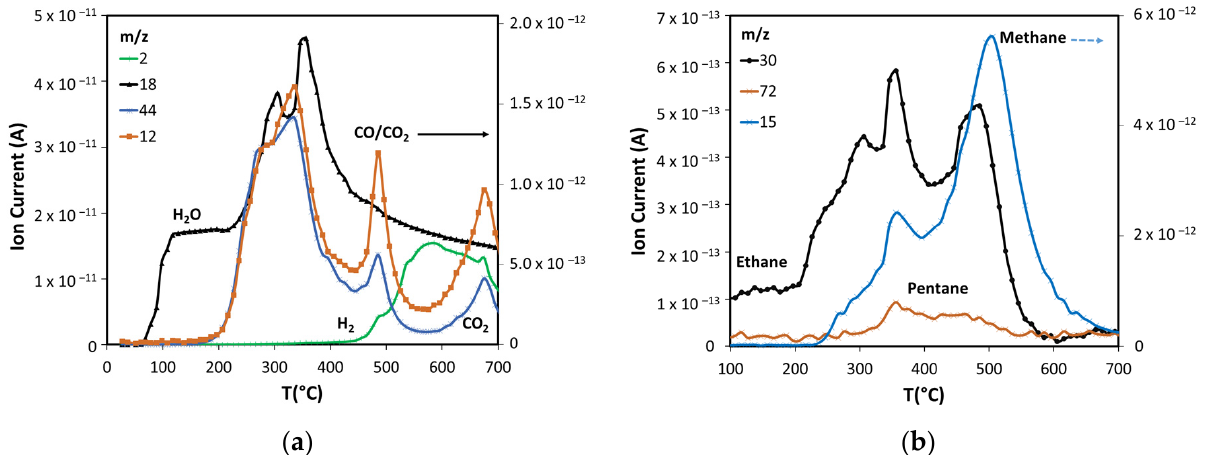
Figure 4. Products formed in non-catalytic pyrolysis of ASB. ( a ) Inorganic compounds. ( b ) Light alkanes.